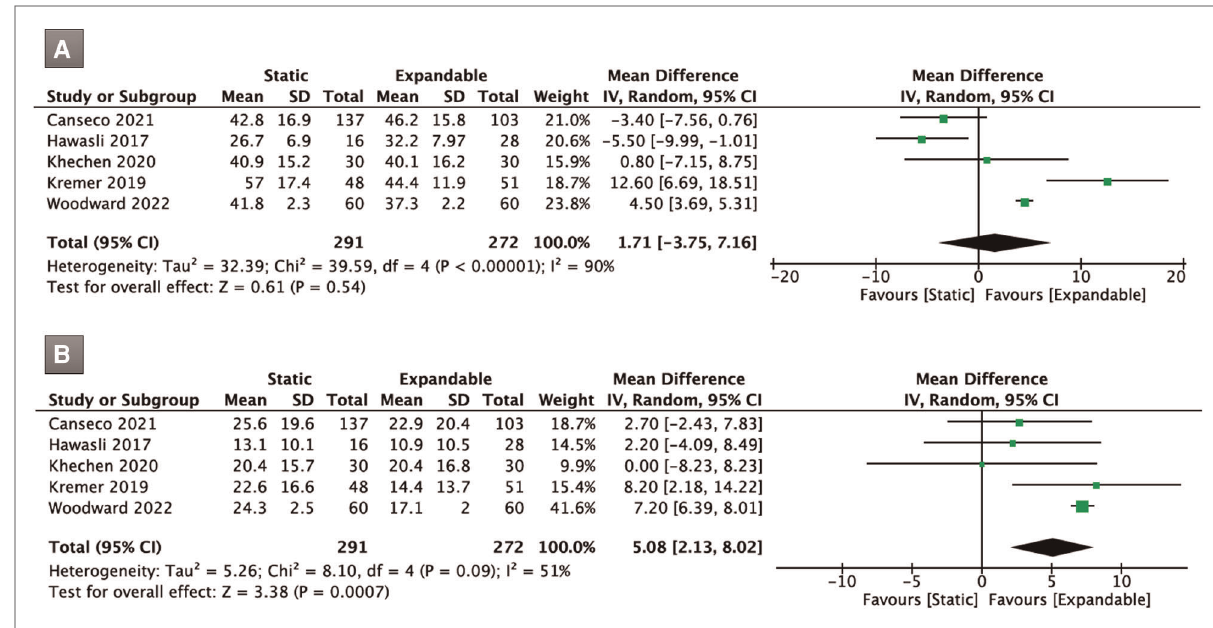
FIGURE 11 Forest plots for comparison of ODI at preoperative ( A ) and fi nal follow-up ( B ) between the static and expandable groups. ODI: Oswestry Disability